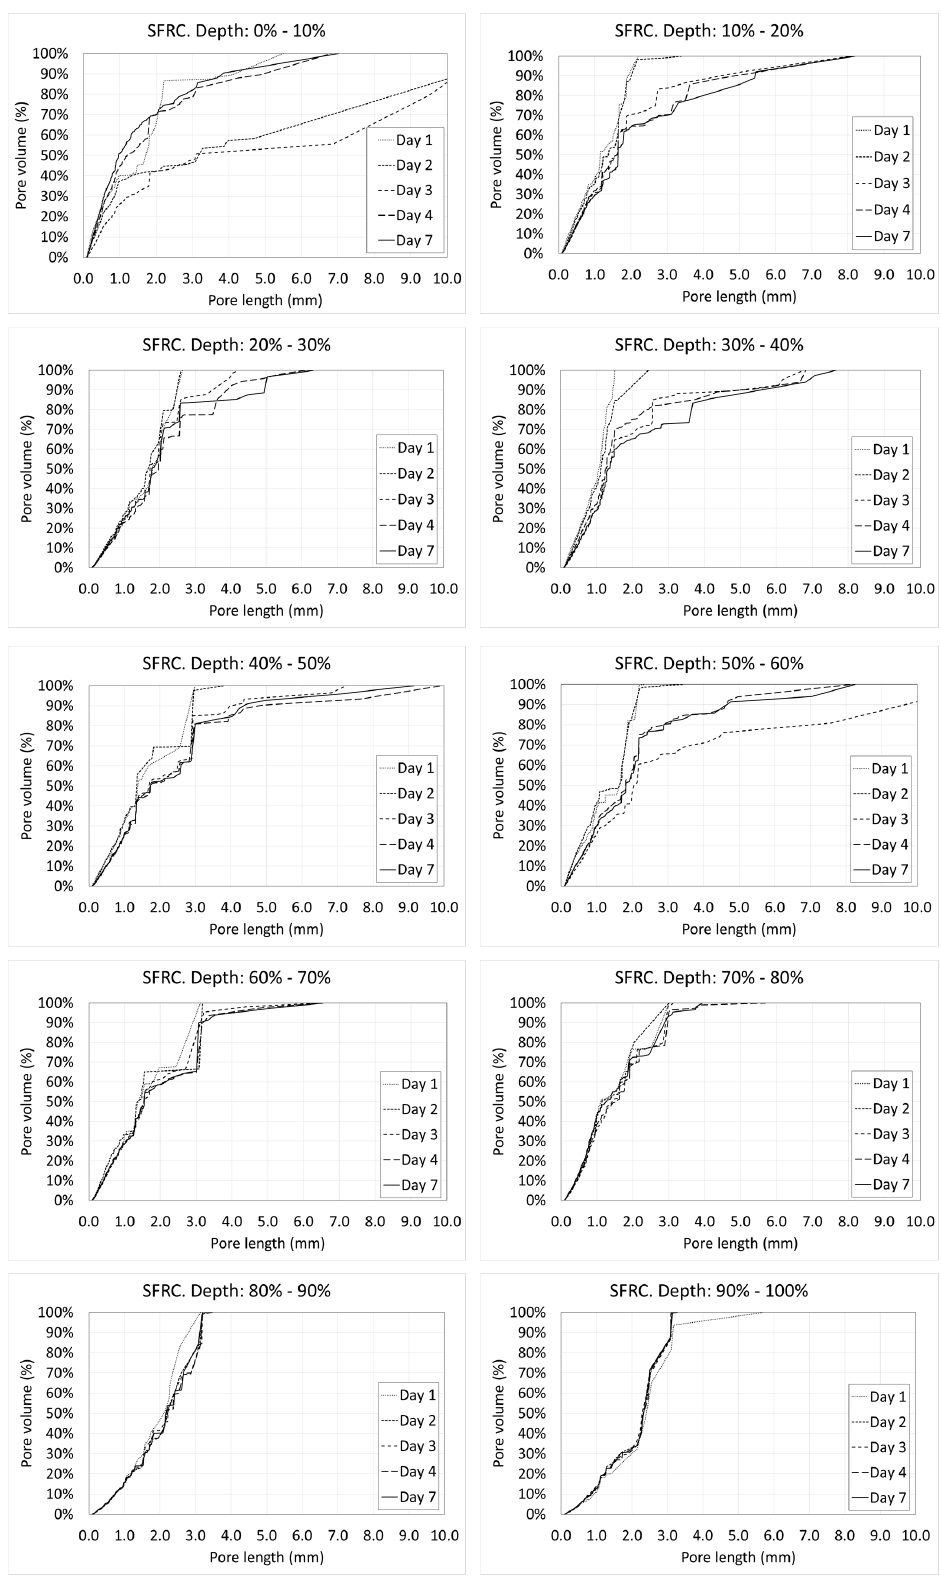
Figure 18. Porosimetric curves of SFRC at different ages and depths.